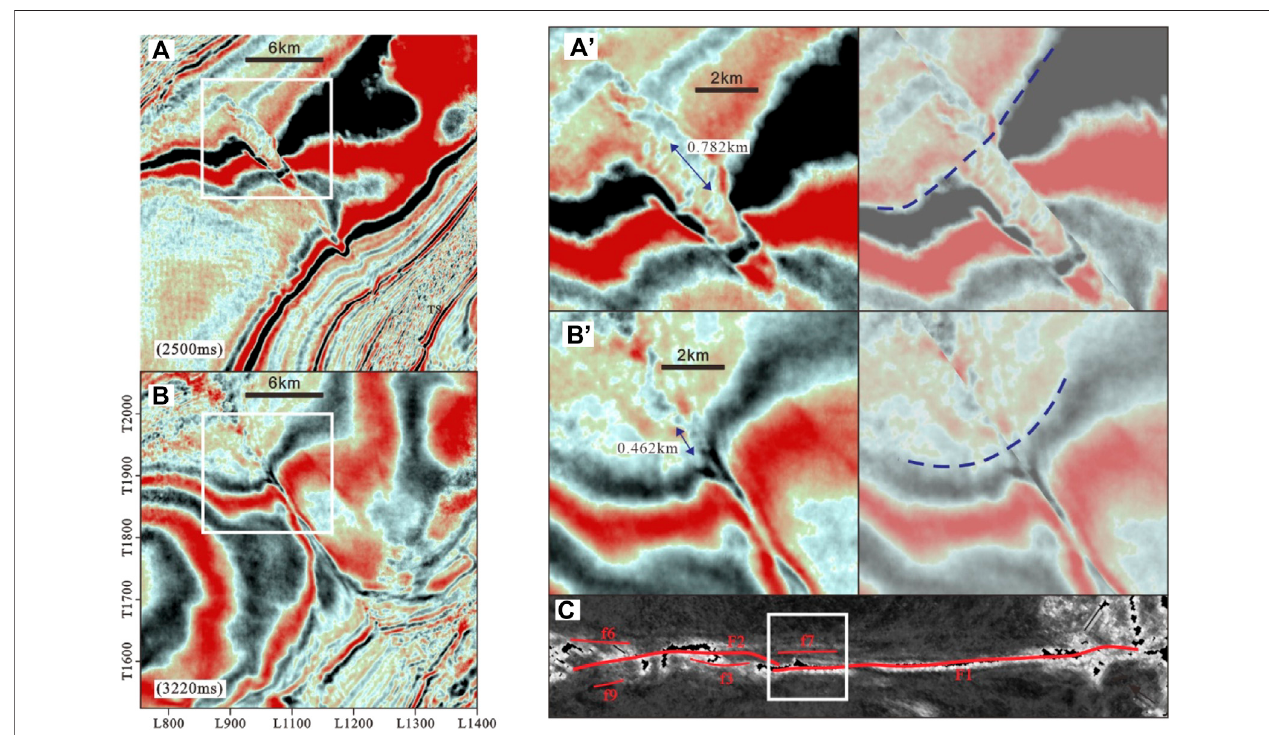
FIGURE 11 | (A) Horizontal time slice at 2500 ms and (B) Horizontal time slice at 3220 ms [see (C) for the locations of (A) and (B) ]. (A`) Horizontal time slice at 2500 msshowing thediscontinuousstrataoffset bythe northern No. 15fault and restoration oforiginalcontinuousstrata. (B`) Horizontal time sliceat 3220 msshowing discontinuous strata offset by the southern SB5 fault and restoration of original continuous strata [see (A) and (B) for the locations of (A`) and (B`) ].